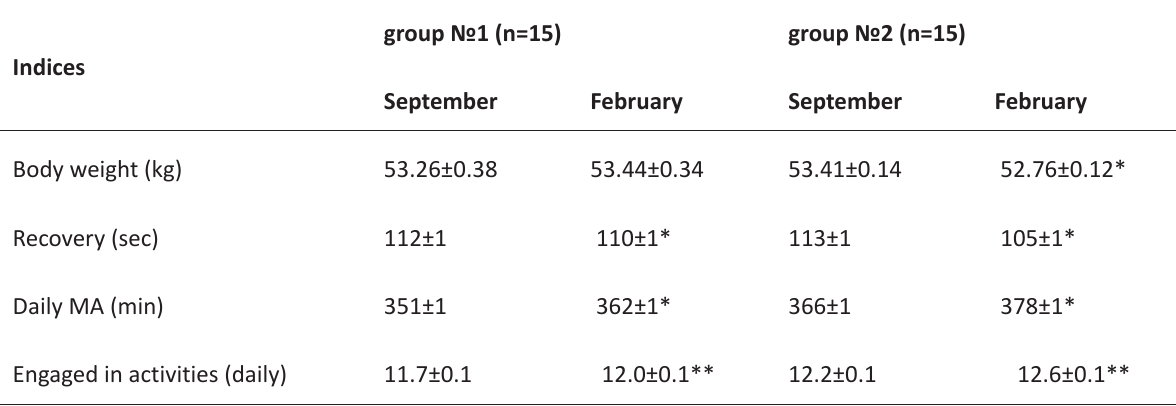
Table 1 . Dynamics of changes in research